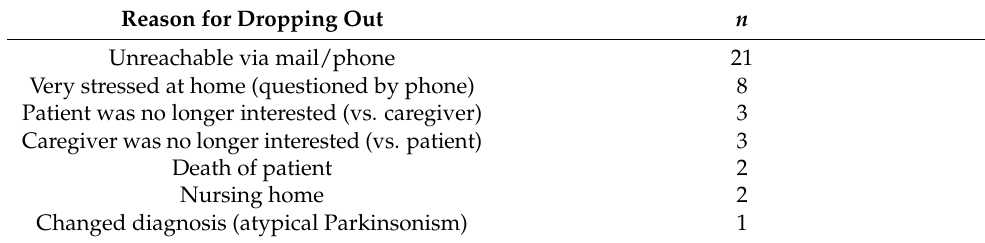
Table A2. Reasons for drop